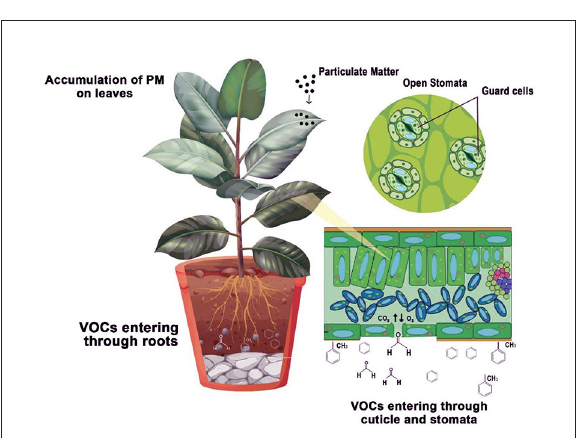
different plant parts in removing indoor pollutants from the surrounding air.